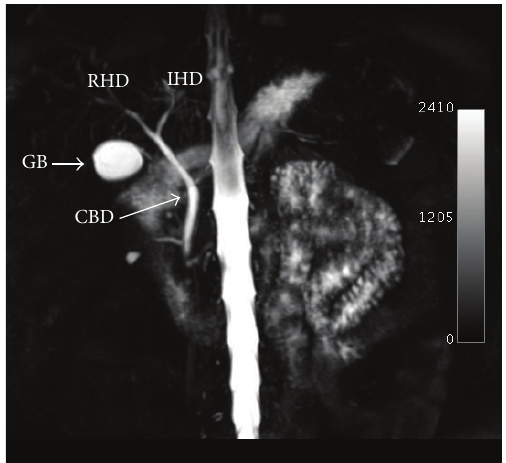
Figure 1: MRCP showing a normal extrahepatic biliary tree and a large gallbladder remnant (GB). CBD: common bile duct; LHD: left hepatic duct; RHD: right hepatic duct.